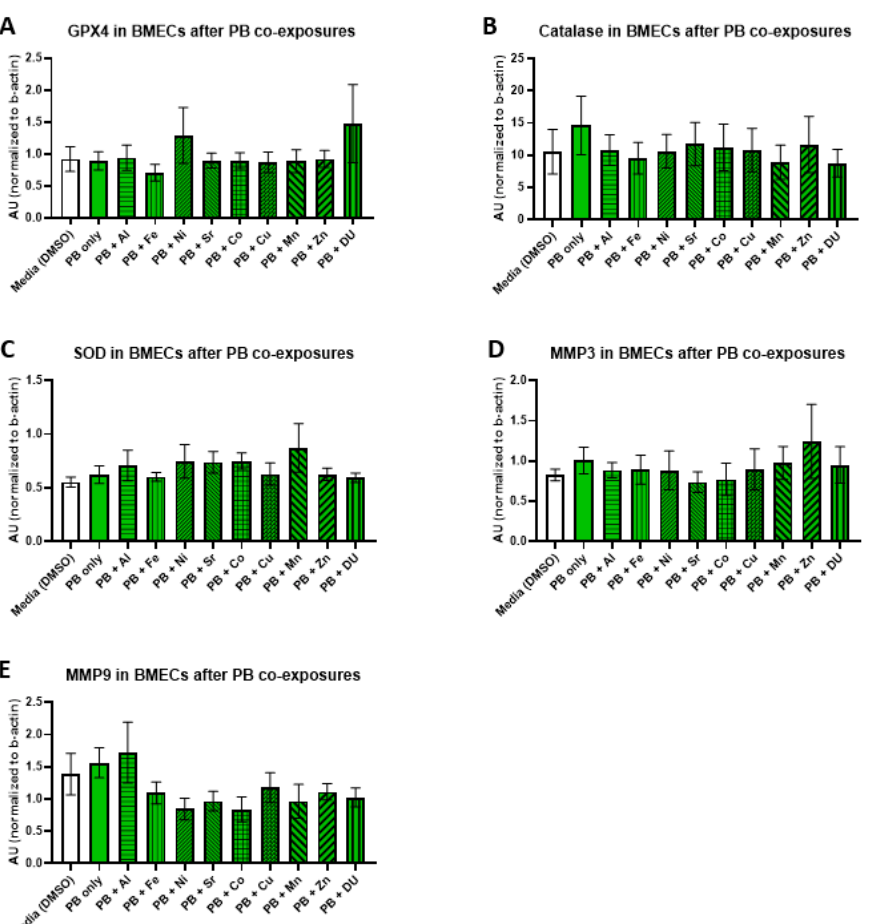
Figure 6. Oxidative stress proteins in brain microvascular endothelial cell (BMEC) cultures after pyridostigmine bromide (PB) and metal exposure. Assessment of several oxidative stress